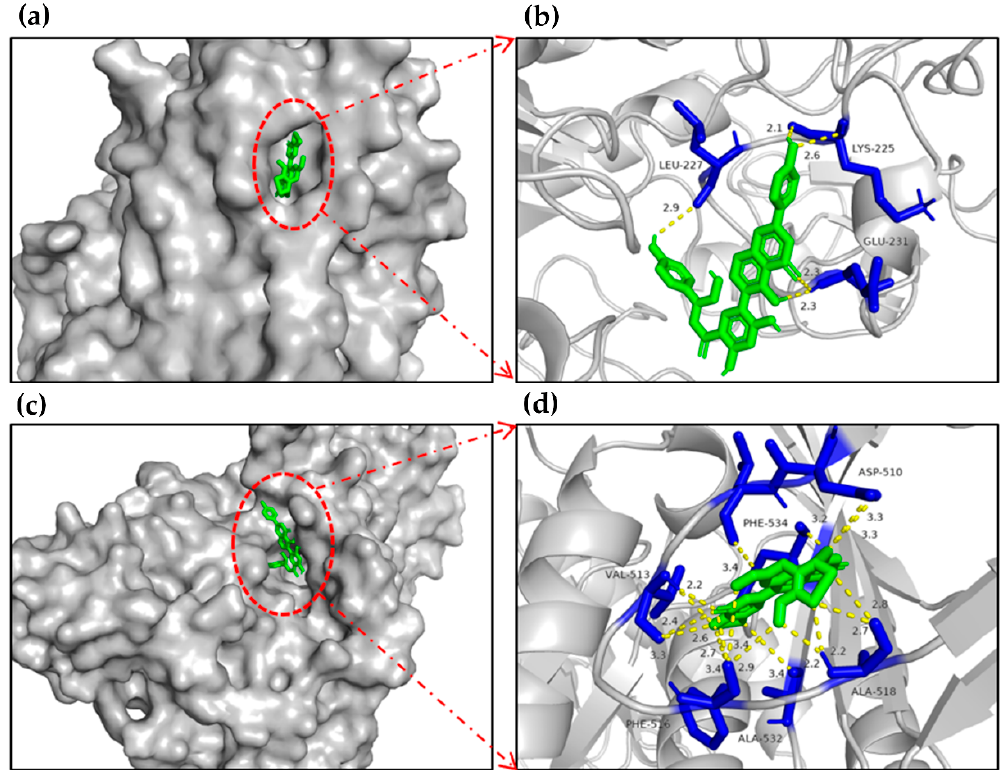
Figure 4. Molecular docking schemes of agathisflavone and delphinidin 3- O - β -D-galactoside on α - glucosidase of 3WY1. ( a ) The surface structure of 3WY1-agathisflavone. ( b ) The binding site struc- ture of 3WY1-agathisflavone. ( c ) The surface structure of 3WY1-delphinidin 3- O - β